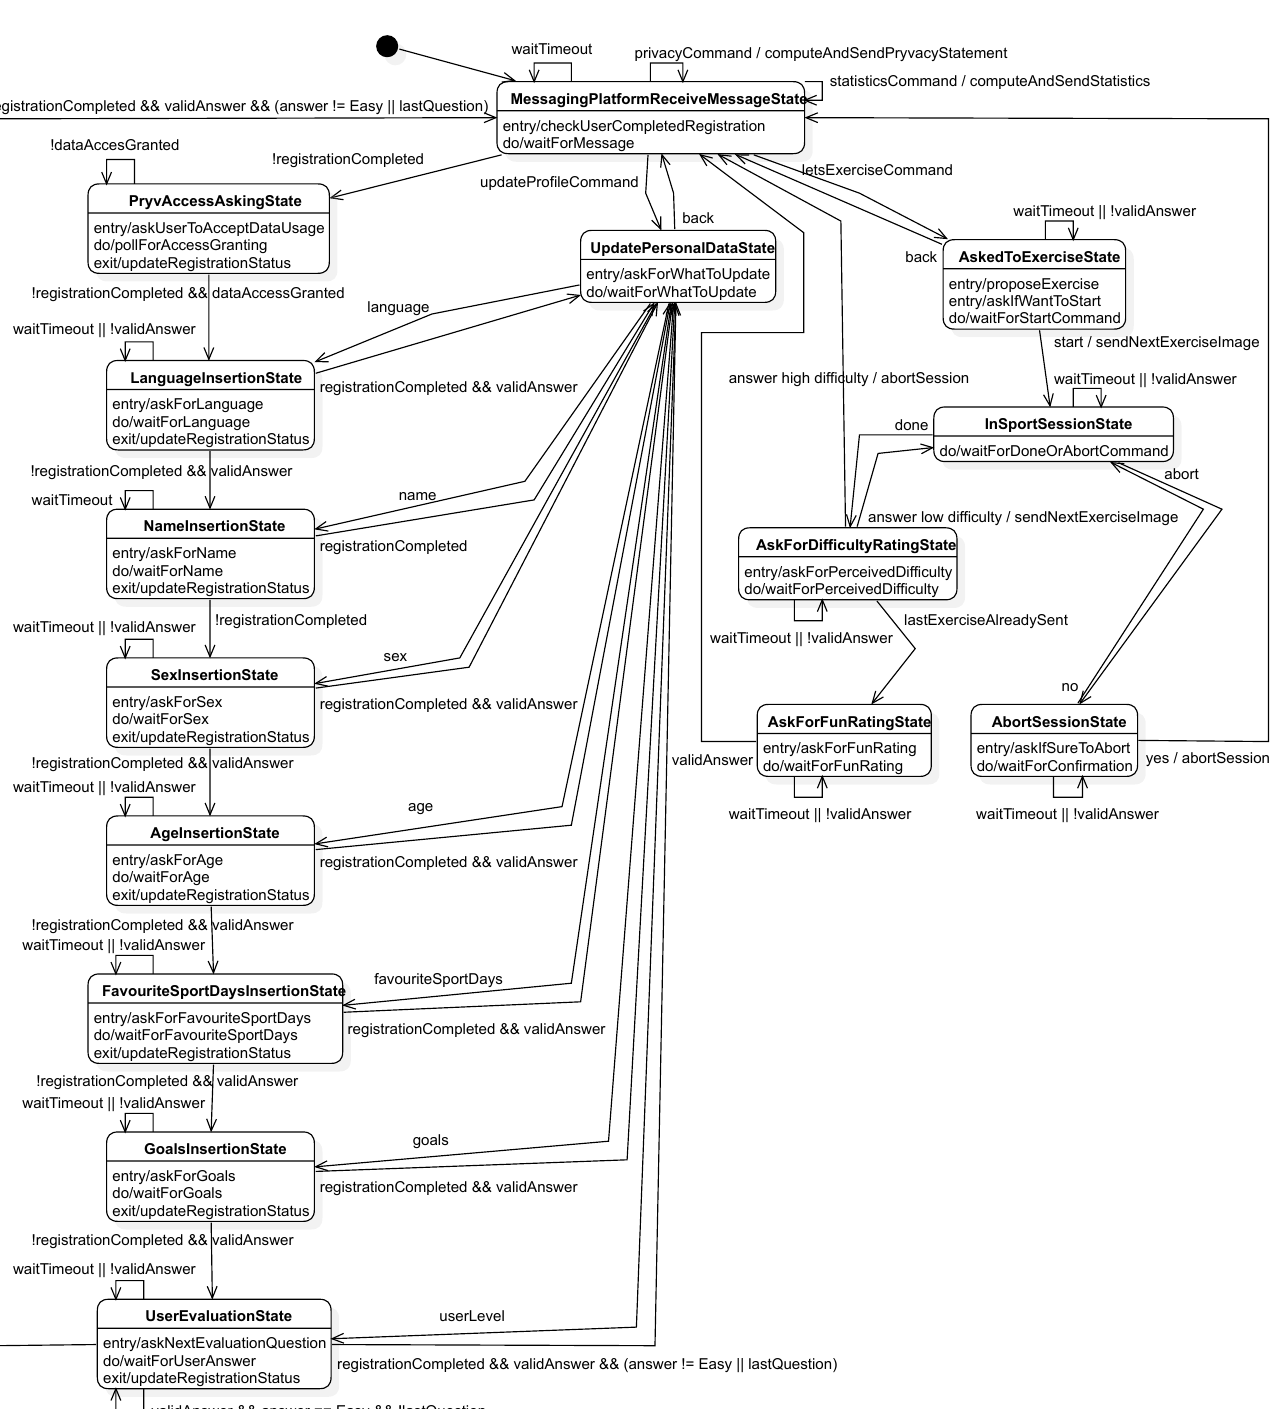
Figure 13. Schematic representation of the UserAgent